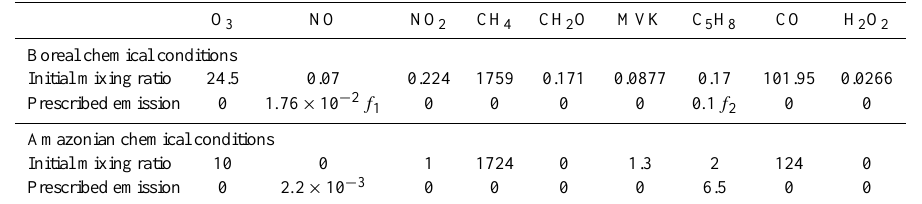
(cid:16) (cid:17)(cid:17) (cid:16) (cid:17) (cid:16) 1 − 1 cos 2 π t − 4 and f 2 = sin 2 π t − 4 can be used with t in hours local daylight saving time. The 2 2 18 18